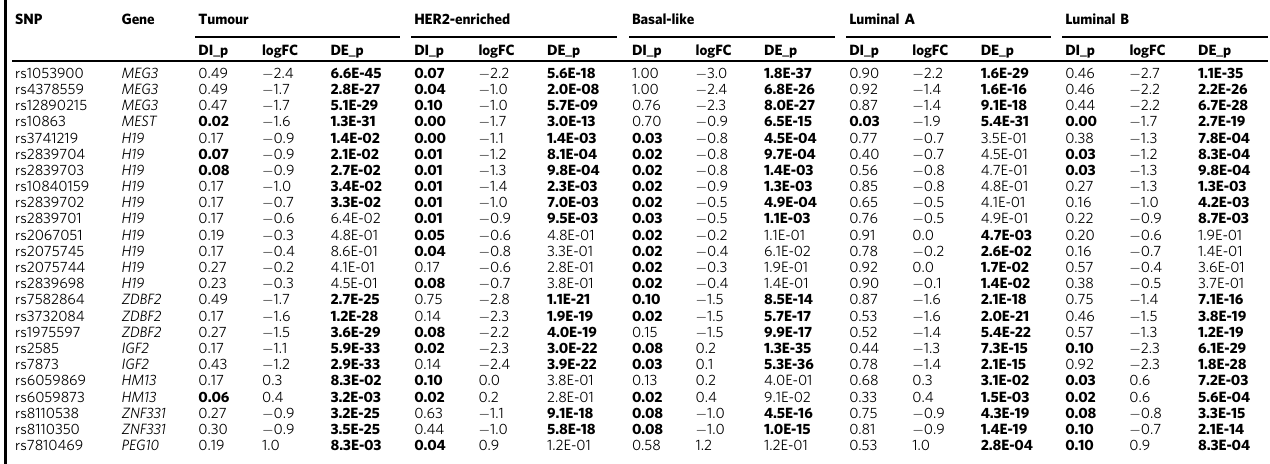
SNP Gene Tumour HER2-enriched Basal-like Luminal A Luminal